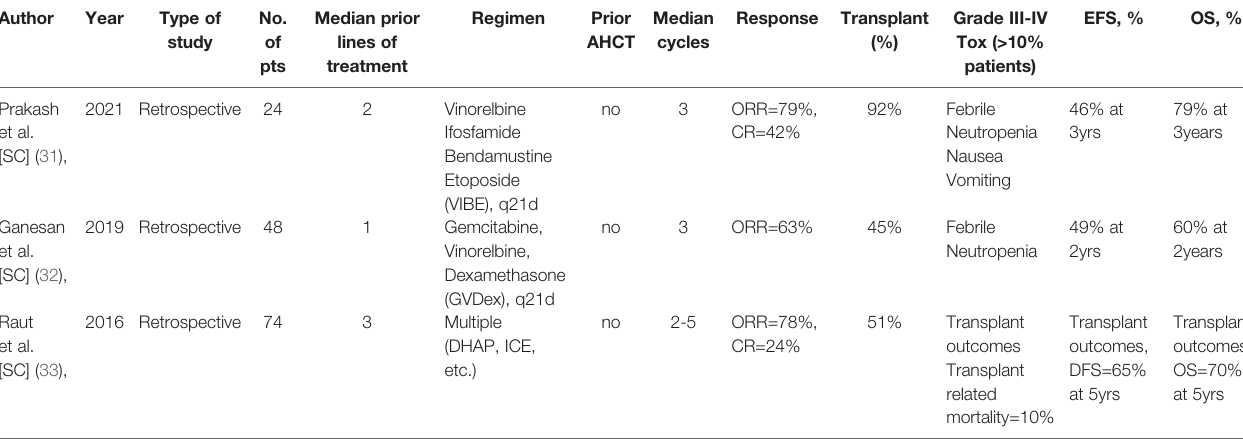
TABLE 4 | R/R HL-Chemotherapy salvage and AHCT, Indian